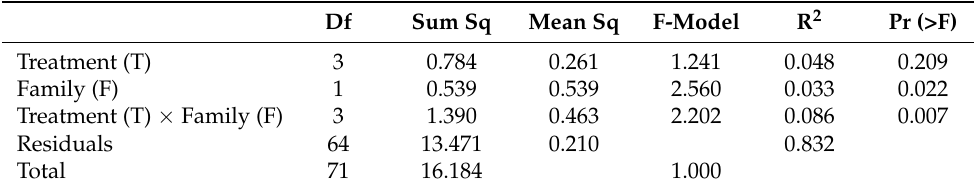
Table 4. PERMANOVA showing variability among fish gut microbiota across all samples originated from the stream substrate (wild). Df Sum Sq Mean